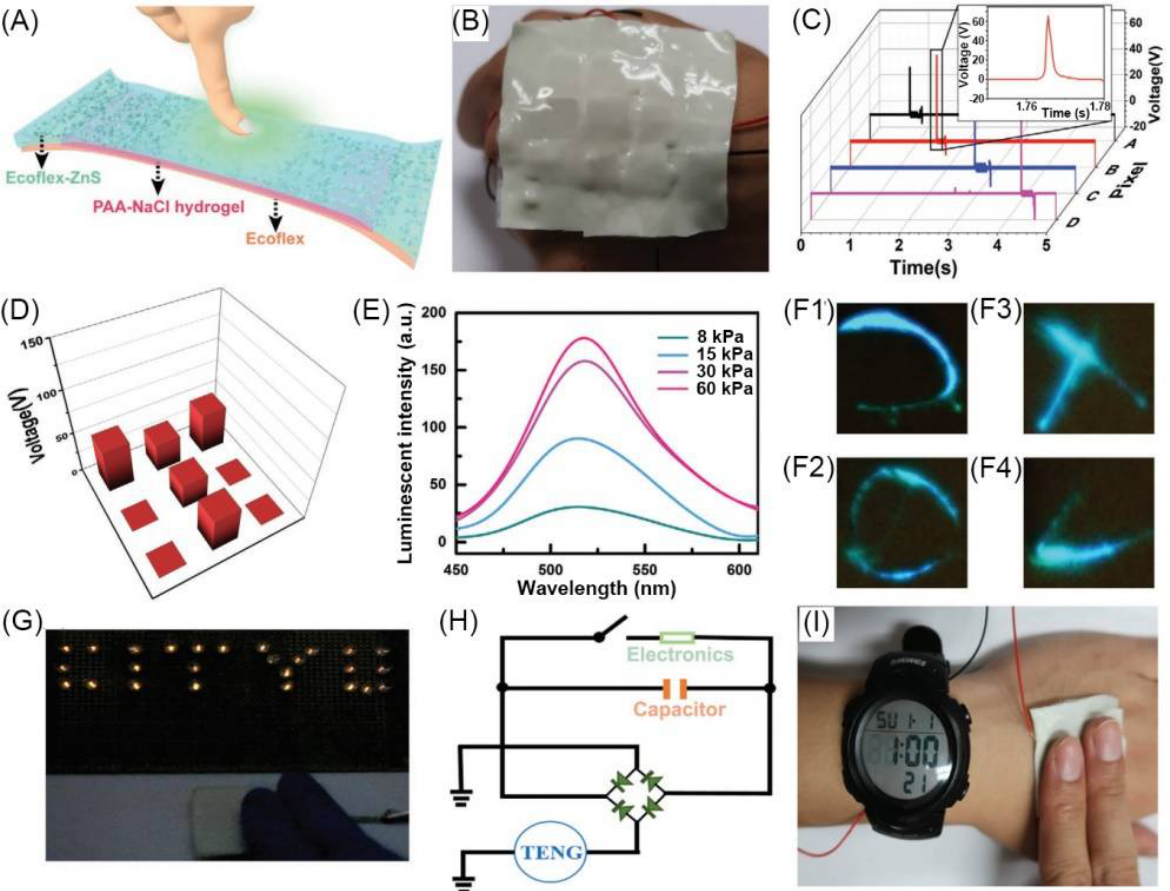
Figure 9. ( A ) Structural configuration of Ecoflex/hydrogel/Ecoflex gel composite-based smart skin device. ( B ) Photograph of the smart skin containing nine hydrogel pixels on back of a hand. ( C ) Electric signals at different pixels for detection of pressure location. ( D ) Voltage signals of nine pixels with a “T” shaped acrylic plate placed on skin. ( E ) Mechanoluminescent intensity of skin at various pressure magnitudes. ( F1–4 ) Photographs of a real-time tracking of ML signals by external force. ( G ) Photograph of smart skin to power LEDs to demonstrate energy-harvesting property. ( H ) Equivalent circuit of a self-charging system to power an electronic watch ( I ). Adapted with permission [27]; copyright 2019, Wiley-VCH Verlag GmbH & Co. KGaA, Weinheim.